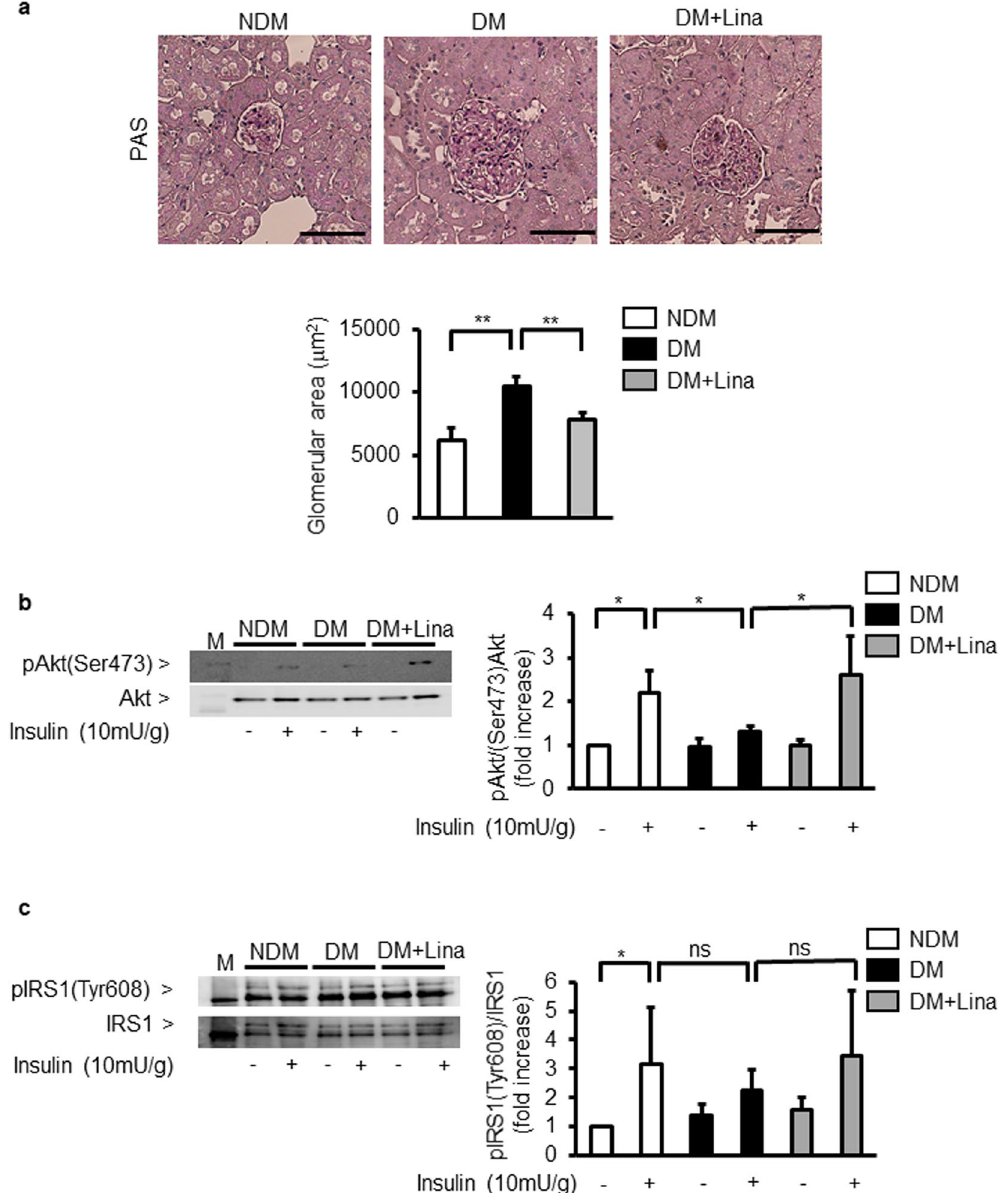
Figure 3. Effect of linagliptin on Akt and IRS1 in the glomeruli of diabetic Sprague-Dawley (SD) rats. ( a ) Representative light microscopic appearance of glomeruli (PAS staining) and morphometric analysis of glomerular area. NDM; nondiabetic SD rats, DM; STZ-induced diabetic SD rats; Lina, linagliptin. Bar = 100 μ m. ** P < 0.01. ( b , c ) Representative immunoblots of tyrosine phosphorylation of Akt ( b ) and IRS1 ( c ) from glomeruli. Solubilized glomeruli were subjected to immunoprecipitation followed by immunoblotting. NDM; nondiabetic SD rats, DM; STZ-induced diabetic SD rats; Lina, linagliptin. * P < 0.05. ns; not significant. These data are expressed as means ± SD. Results are representative of one of three independent